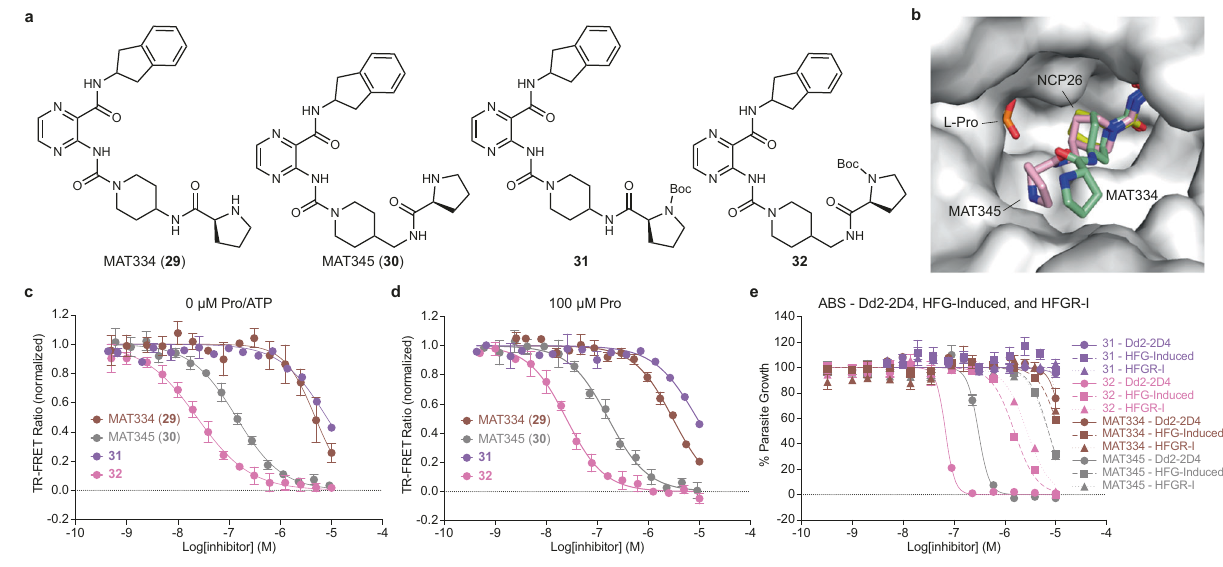
Fig. 4 | Dual-site ProRS inhibitors. a Chemical structures of pyrazinamide- proline hybrids (absolute stereochemistry). b Overlay of the co-crystal struc- tures of Pf cProRS (gray surface) in complex with proline (orange sticks) and either NCP26 (PDB: 6T7K, yellow sticks), MAT334 ( 29 ) (PDB: 7QC2, green sticks),andMAT345( 30 )(PDB:7QB7,pinksticks)showstheprolyl-substituents of MAT334 and MAT345 pointing outside the active site. Dose-response titra- tion of pyrazinamide-proline hybrids using CoraFluor-1-labeled HT- Pf cProRS (0.25 – 1nM) and MAT379 as tracer at 2.5x K D (250nM) in the absence ( c ) or presence of 100 μ M Pro ( d ). See Supplementary Fig. 17 for corresponding data withHT- Hs ProRSinthepresenceorabsenceof100 μ MPro. e Invitroactivityof